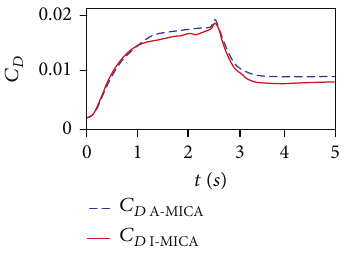
Figure 16: Variation curve of drag coe ffi